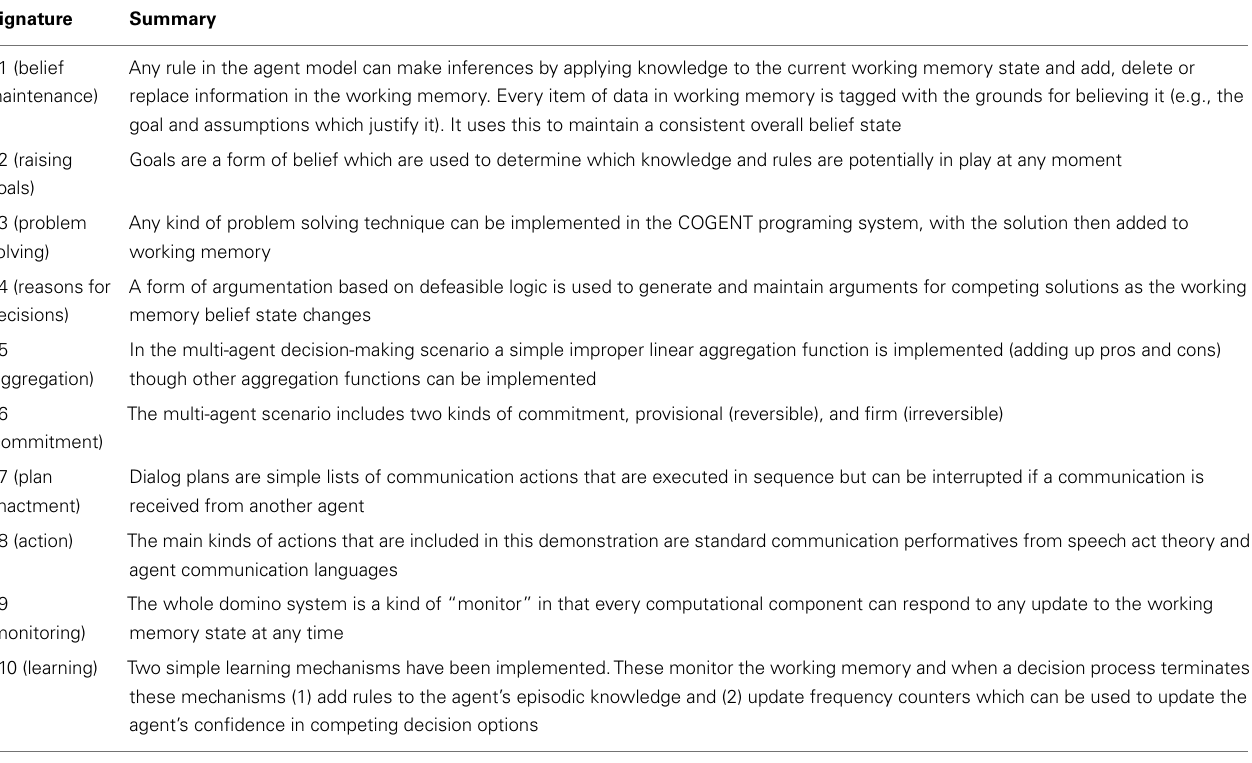
Table 4 |The relation between the canon signatures and functions which are implemented in the multi-agent decision-making